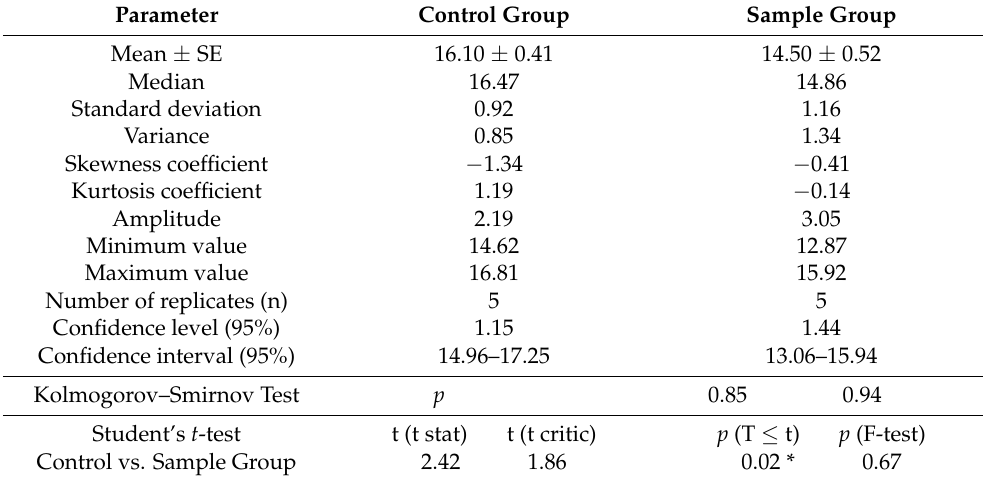
Table 6. Data processing of hemoglobin values (Hb as g/dL).